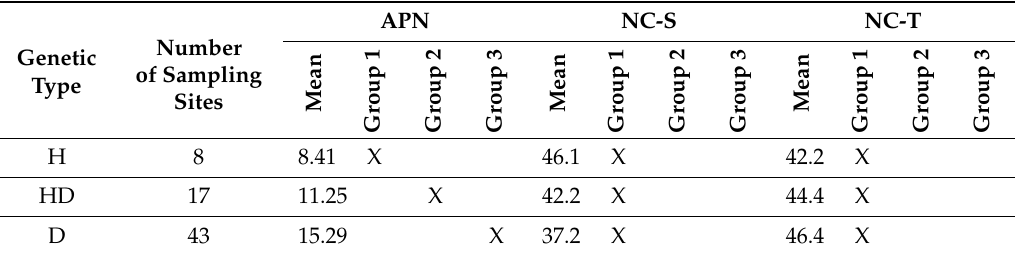
Table 2. The results of Games–Howell test for homogeneous genotype groups of polymetallic nodule abundance (APN), nodule coverage of seafloor (NC-S), and nodule coverage of grid at a significance level ∝ = 0.05 (homogeneous groups are marked by X placed in the same column).